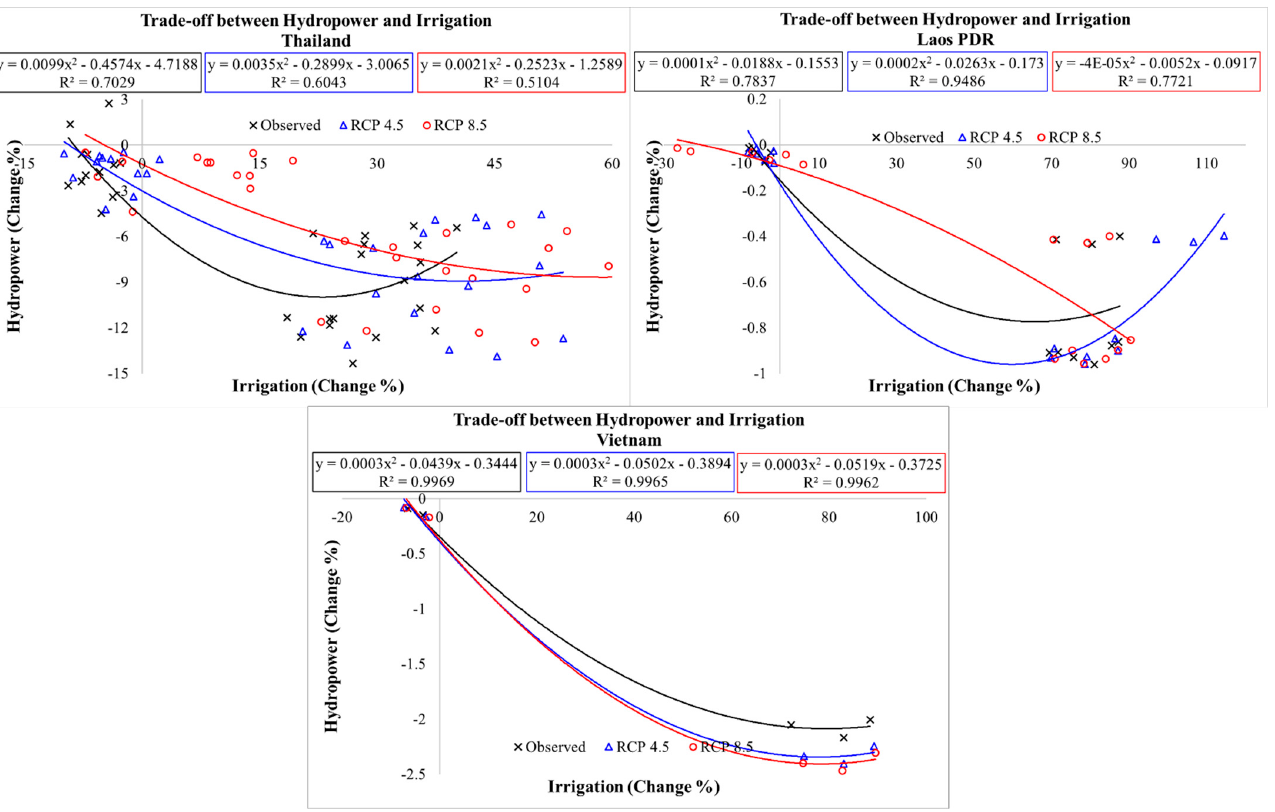
Figure 5. A tradeoff between the energy (% change) and irrigation (% change) sectors based on the six scenarios of agricultural expansion for the multipurpose dams in the MRB for the observed (black) and future period under RCP 4.5 (blue) and RCP 8.5 (red). The slope, equation, and goodness of fit of a linear trendline are estimated (R2).